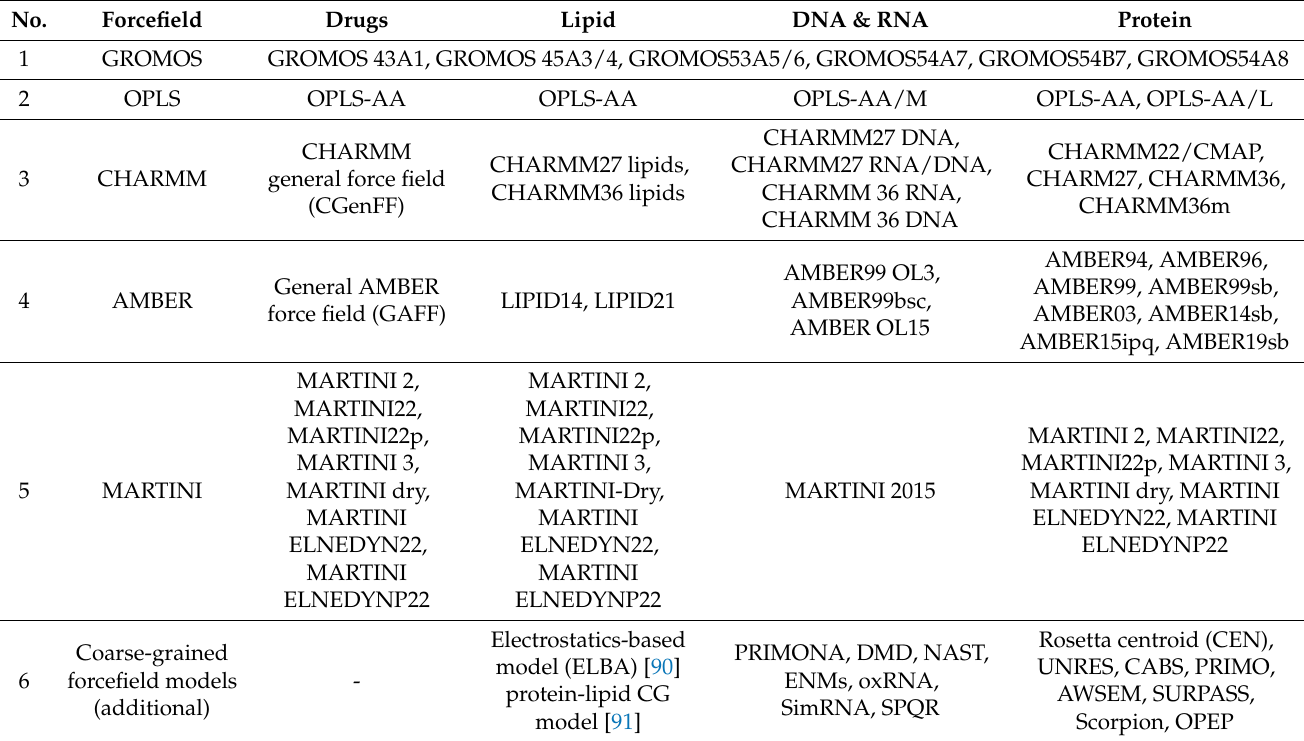
Table 1. Atomistic and coarse-grained forcefield in MD